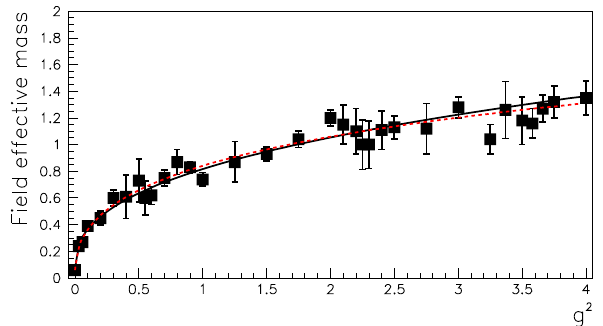
Fig. 4 The g 2 -dependence of the effective mass generated by the quar- tic term g 2 φ 4 . The contin u o u s line is a polynomial fit to the data and the dashed line is a logarithmic fit. The simulation used a lattice size N = 55, N s = 5 × 10 4 configurations, a decorrelation coefficient N cor = 15 and random field boundary